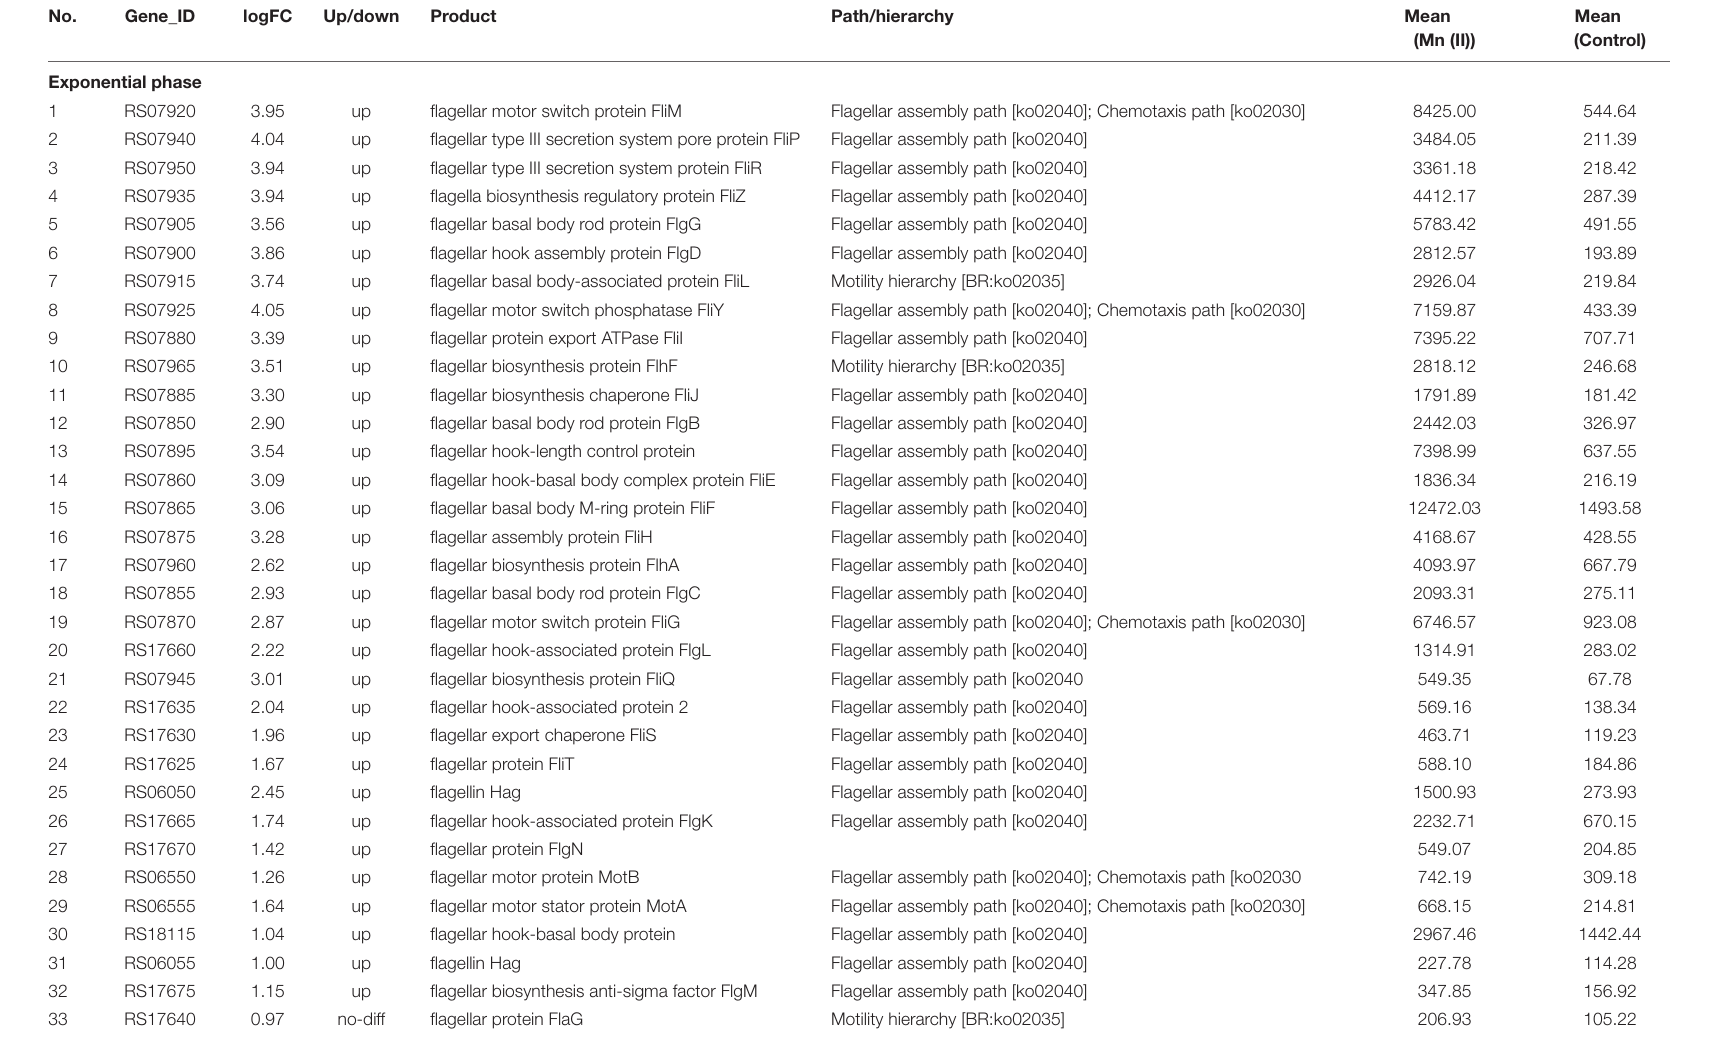
TABLE 5 | Flagellar genes expressed in exponential and stationary growth phases of strain ST7 exposed to manganese.